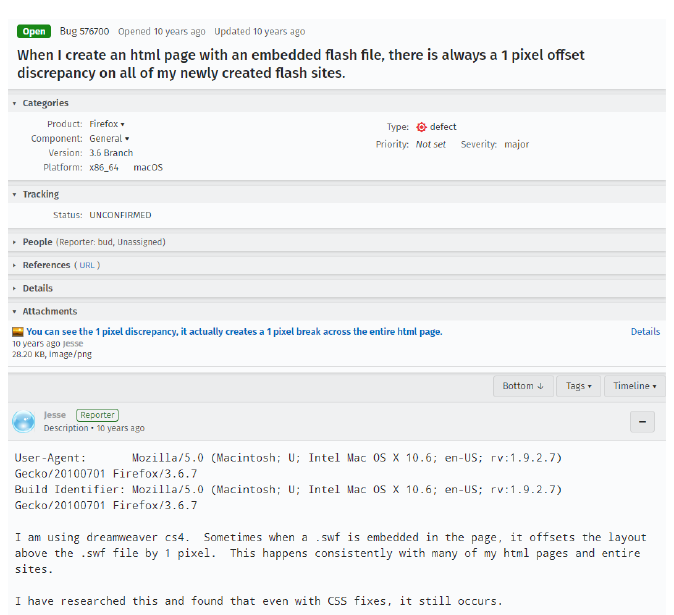
Figure 1. An example of Mozilla Firefox bug report #576700.